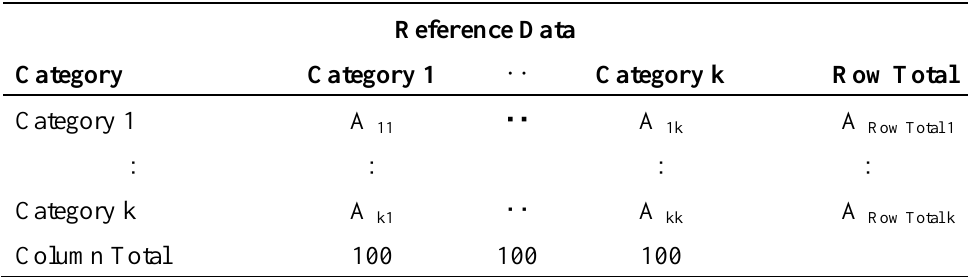
Table 1. Error matrix for classification map A.